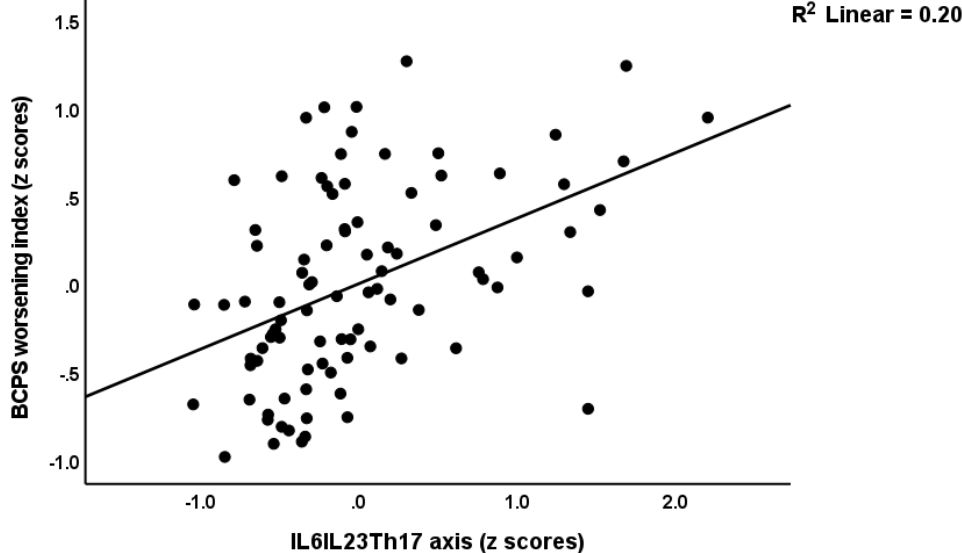
Figure 5. Partial regression of the BCPS (behavior-cognitive-psycho-social) worsening index, a latent vector extracted from three Sheehan disability domains and four WHO-QoL (Quality of Life) domains, the generalized cognitive decline and the symptomatome on the IL6IL23Th17 (interleukin—T helper) axis severity, computed in the restricted group of schizophrenia patients after adjusting for the effects of confounders.